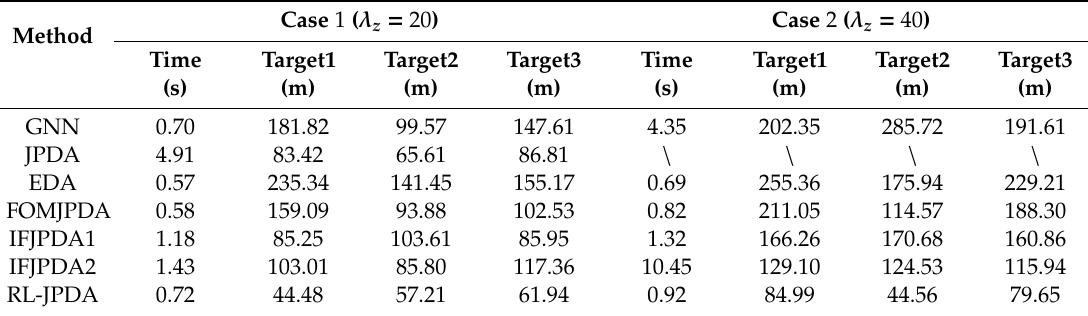
Table 2. RMS errors and execution time of the two